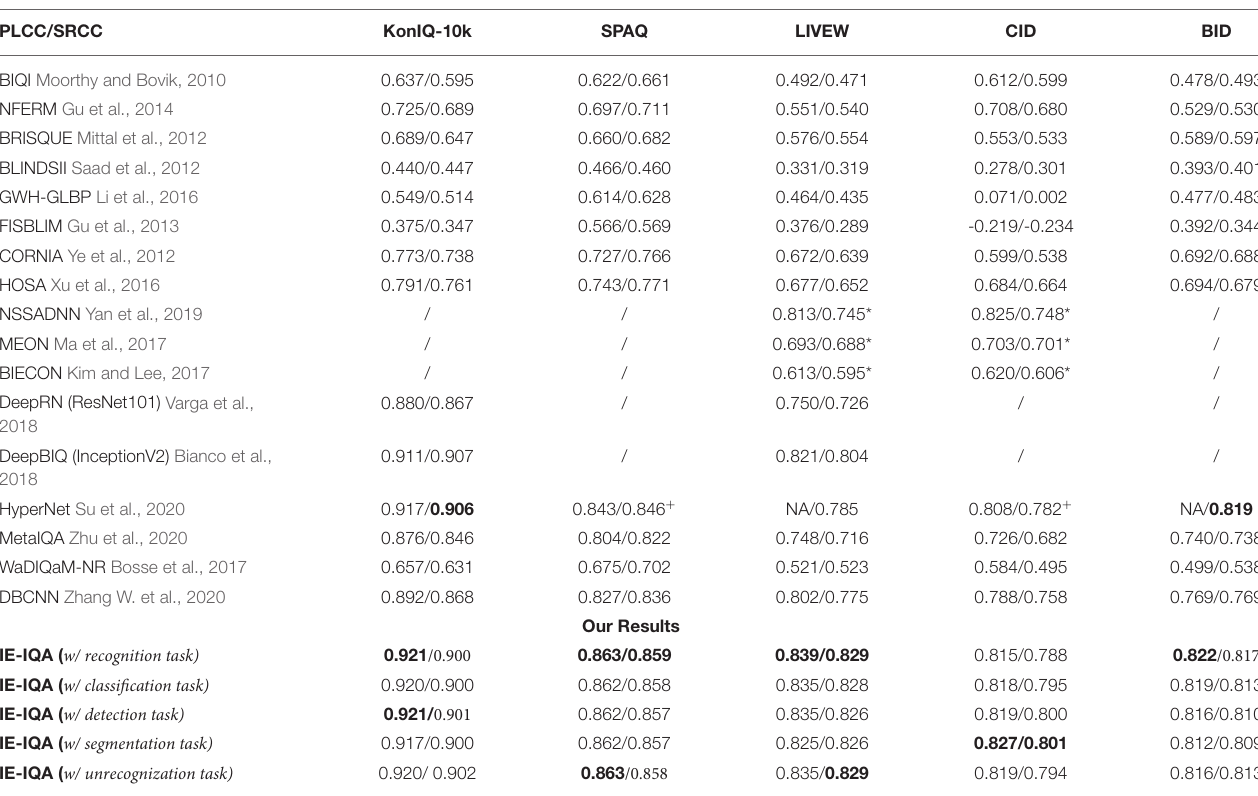
TABLE 1 | Pearson’s linear correlation coefficient (PLCC)/Spearman’s rank order correlation coefficient (SRCC) results of cross-dataset test. PLCC/SRCC